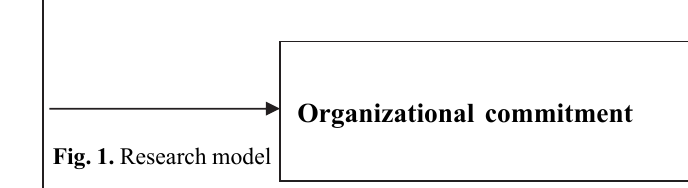
Organizational Fig. 1. Research model